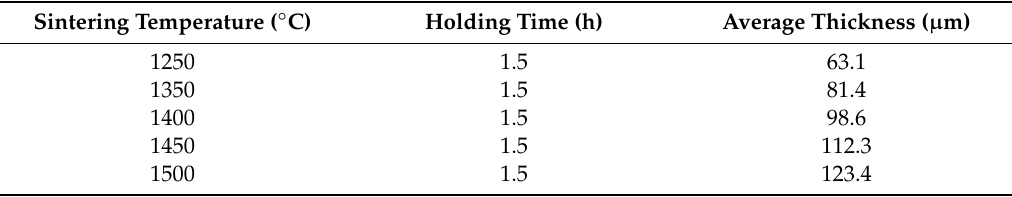
Table 1. Interfacial reaction layer thickness at different sintering temperatures.